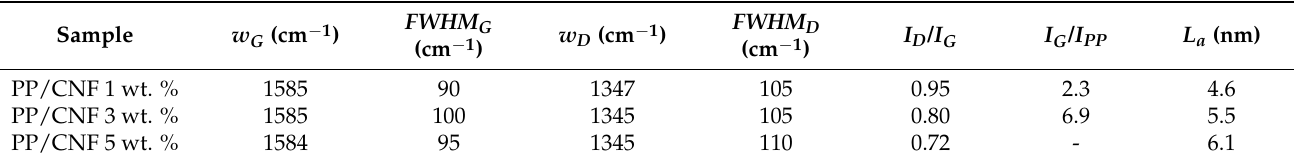
Table 1. w G and w D modes and corresponding to FWHM G and FWHM D , I D / I G , I G / I PP , and L a of PP/CNF composites with 1, 3, and 5 wt. % of